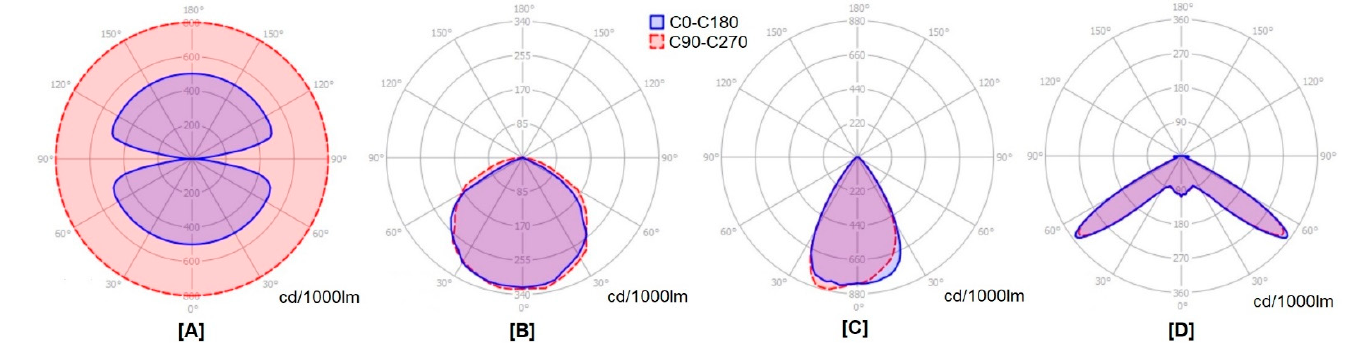
Figure 2. Common photometric diagrams found in led lamps for in vitro culture. ( a ) Fluorescent tube lamp ( b ) 120° hemispheric distribution (regular pattern of most HP LEDs without external lenses) ( c ) 60° concentrated distribution (regular pattern of many HB LED without external lenses). ( d ) Homogenized 120° distribution. Optimal lens design for chambers (i.e., PMMA C17720 EMERALD lens by Ledil).